Question: Sum up the contents of this chart in one sentence.
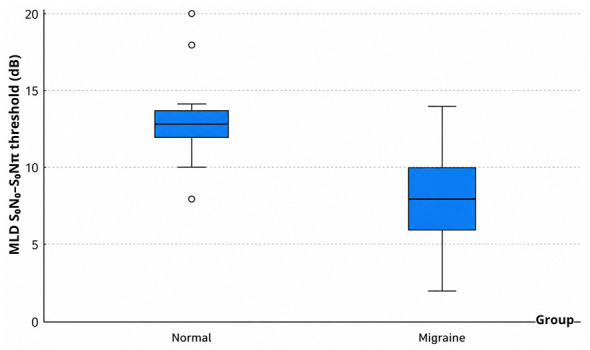
Answer: Comparison of MLD S 0 N 0 –S 0 Nπ of the two groups.